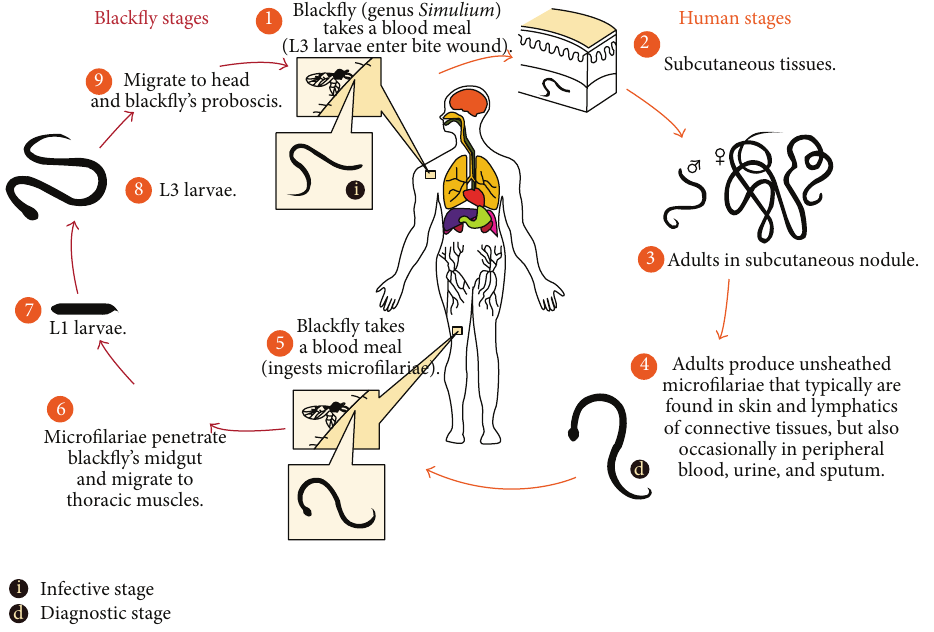
Figure 1: Life cycle of Onchocerca volvulus [8].